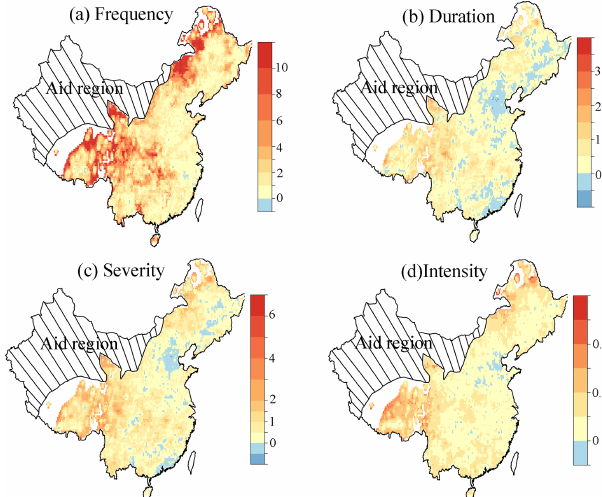
Figure 12. Relative climate model biases in the characteristics of compound dry and hot events in China. The biases are computed as the ratio of the difference between model and observational values to the observational values. The definitions of the frequency, du- ration, severity, and intensity are the same as Fig. 10. White color indicates there are no events. The periods are from 1961 to 2005. The threshold in run theory is − 0 .